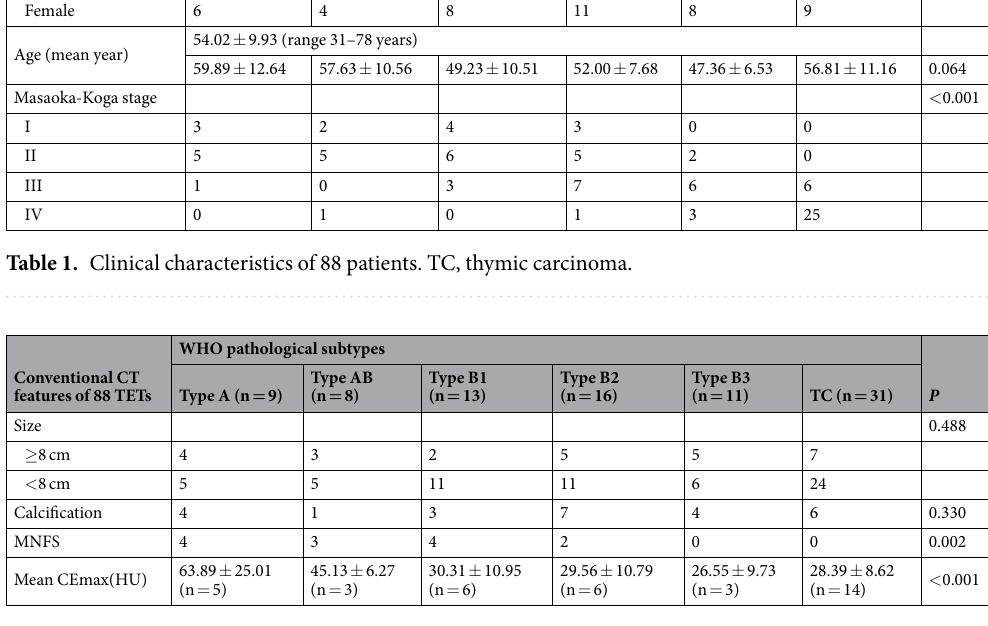
Table 2. Relationship between some conventional CT features and WHO histologic subtypes in the 88 TETs. MNFS, multiple nodule with fibrous septum. CEmax, the maximal contrast-enhanced range. TC, thymic